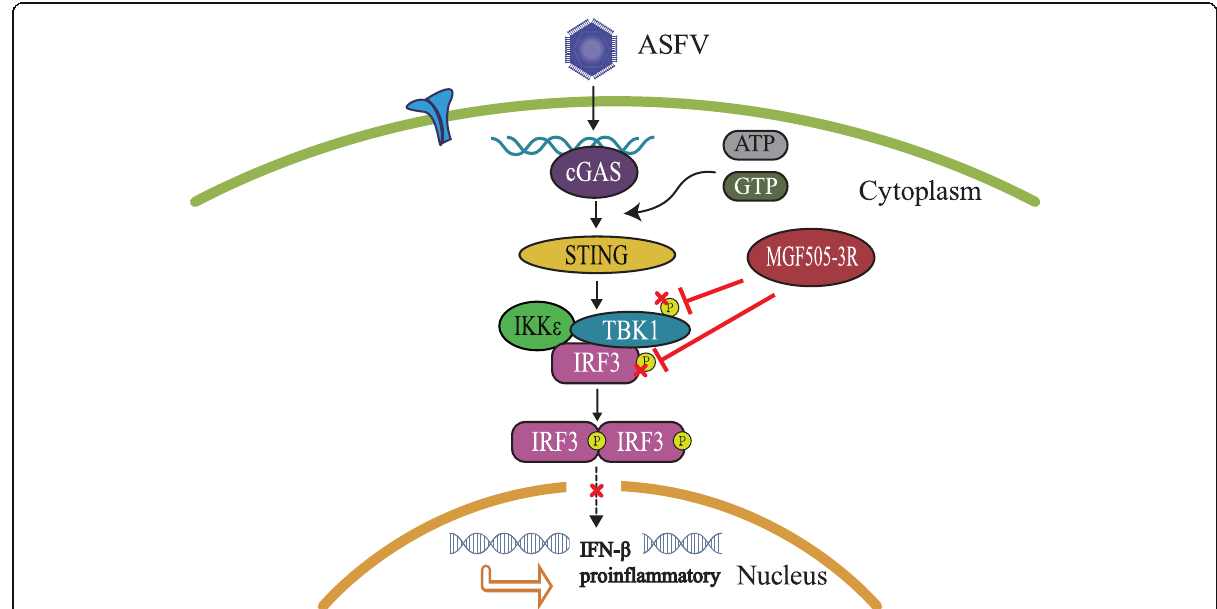
Fig. 7 Schematic representation of ASFV MGF505-3R targeting TBK1 to inhibit IFN- β activity. MGF505-3R negatively regulates the IFN- β signaling axis by interacting with TBK1 and inhibiting the phosphorylation of TBK1 and IRF3, which may be achieved through the induction of autophagy. In addition, MGF505-3R inhibits the phosphorylation of I κ B α , leading to reduced expression of early production of proinflammatory